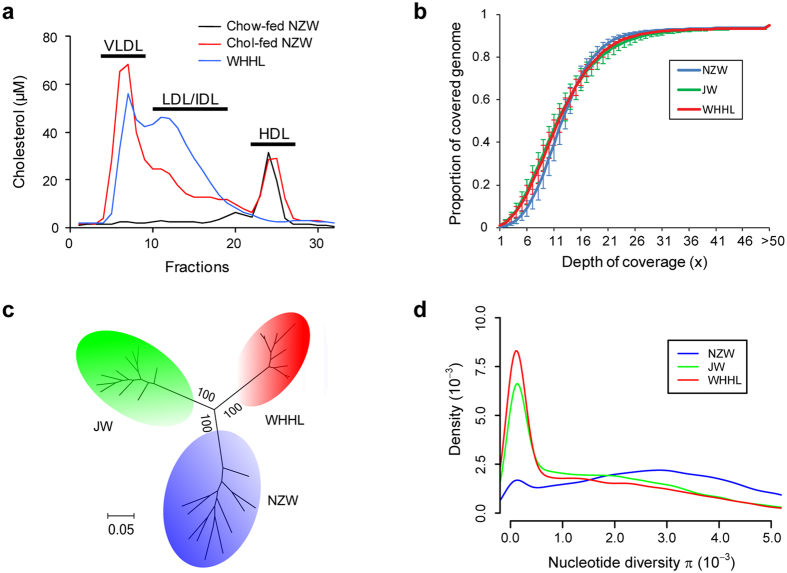
Whole-genome sequencing of laboratory rabbits.(a) Lipid profiles of standard chow-fed NZW, Chol-fed NZW and WHHL rabbits analyzed by high performance liquid chromatography. The Chol-fed NZW showed elevated β-VLDLs, and the WHHL rabbits showed increased LDLs and reduced HDLs. (b) Cumulative distribution of depth of coverage for whole-genome sequencing. The average depth of coverage was 13×  for each individual rabbit. (c) Phylogenic tree of the rabbits. The tree was constructed on the basis of representative SNPs with the maximum likelihood method. Bootstrap values are marked on the branch. (d) Distribution of nucleotide diversity π. The statistics were calculated for every 100 kb sliding-window across the genome.